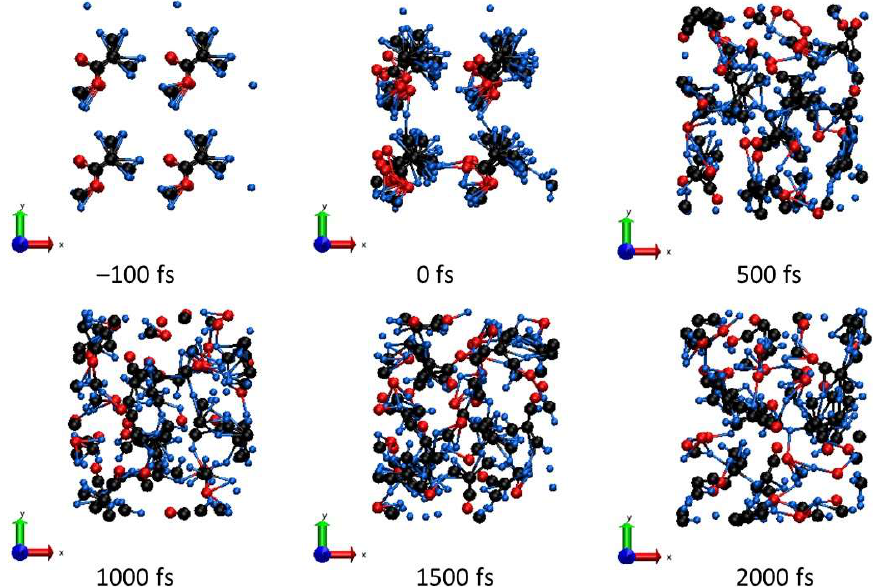
Figure 6. Atomic snapshots of the PMMA supercell irradiated with 0.5 eV/atom at different time instants.